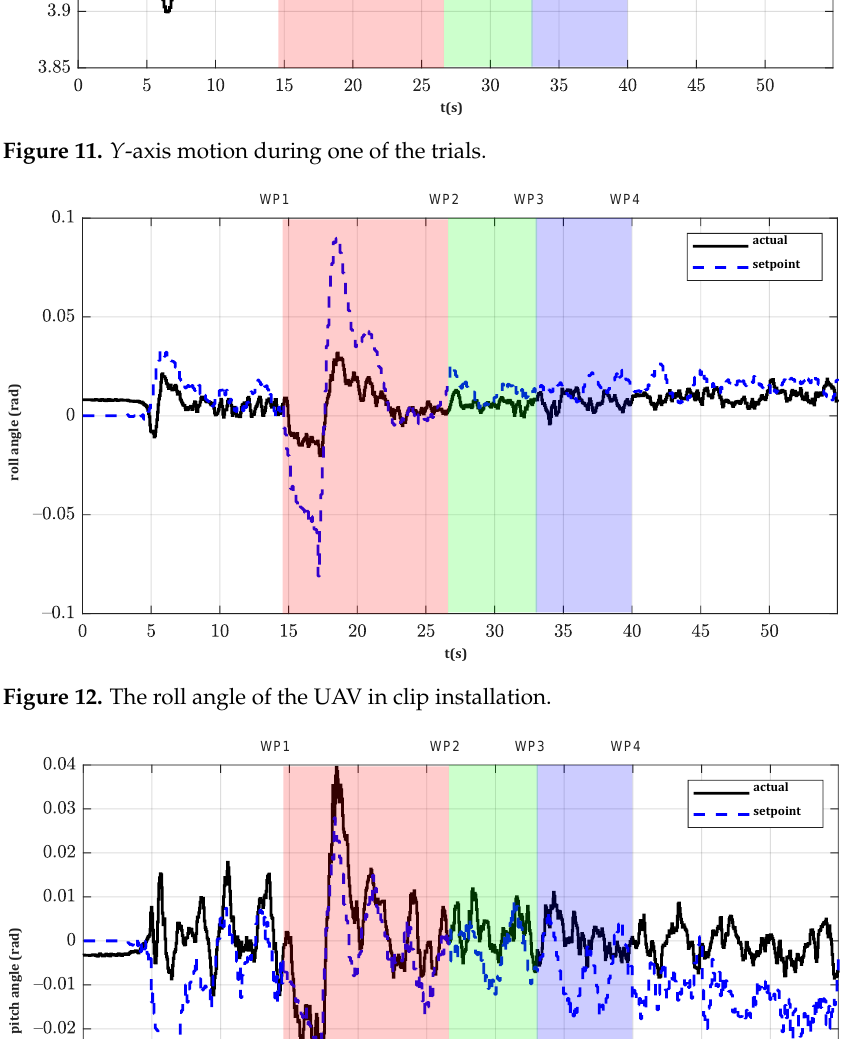
Figure 11. Y -axis motion during one of the trials.